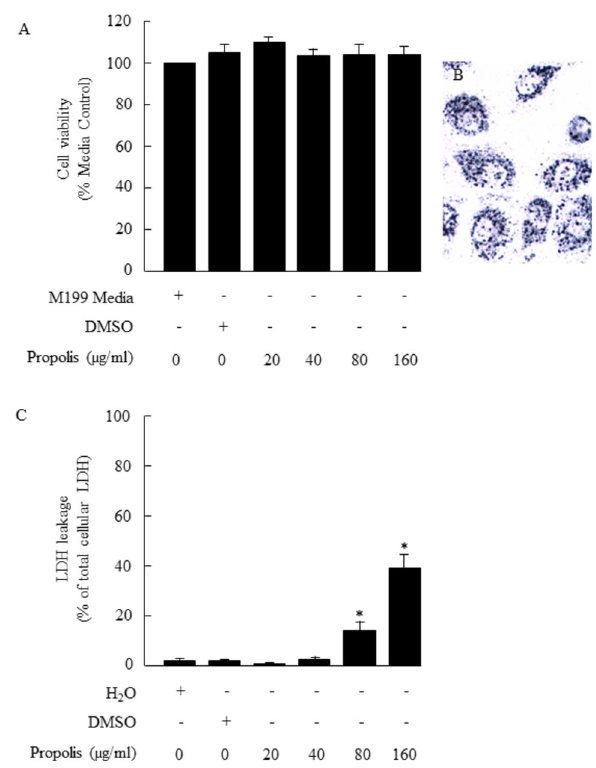
Figure 4. Cell viability assays. MTT assay showing cell viability for human cultured umbilical vein endothelial cells (HUVECs) exposed to stingless bee T. carbonaria propolis or dimethyl sulfoxide (DMSO) for 90 min at 37°C (A). Propolis (20-160 µg/ml) and isovolumetric DMSO (0.26%) had no effect on cell viability. A punctuate pattern of formazan crystal staining was evident in the cytoplasm of HUVECs treated with 160 µg/ml propolis for 90 min at 37°C, confirming retention of mitochondrial enzyme activity (B). Propolis (80 and 160 µg/ml) caused some leakage of lactate dehydrogenase (LDH) into the culture medium (C). Water, DMSO (0.26%) and propolis (20 and 40 µg/ml) had no effect on LDH leakage. doi: